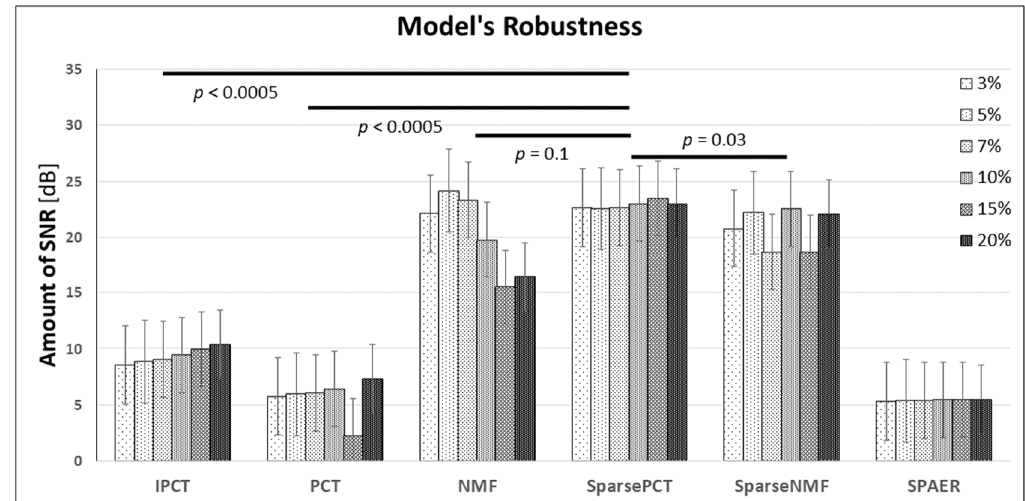
Figure 6. The robustness of the model in the presence of Gaussian additive noise following our signal-to-noise ratio (SNR) definition for all the parts of the model.